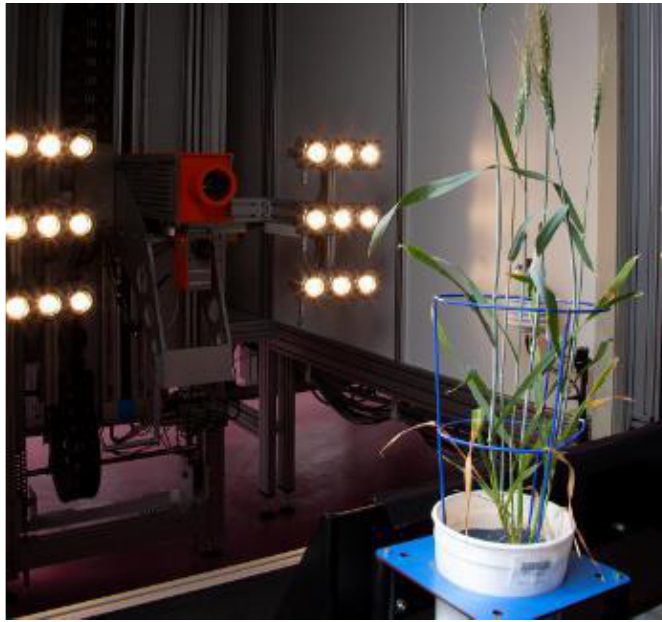
Figure 4. Present the process of hyperspectral image acquisition by two cameras (FX 10 and SWIR cameras) in WIWAM hyperspectral imaging system.